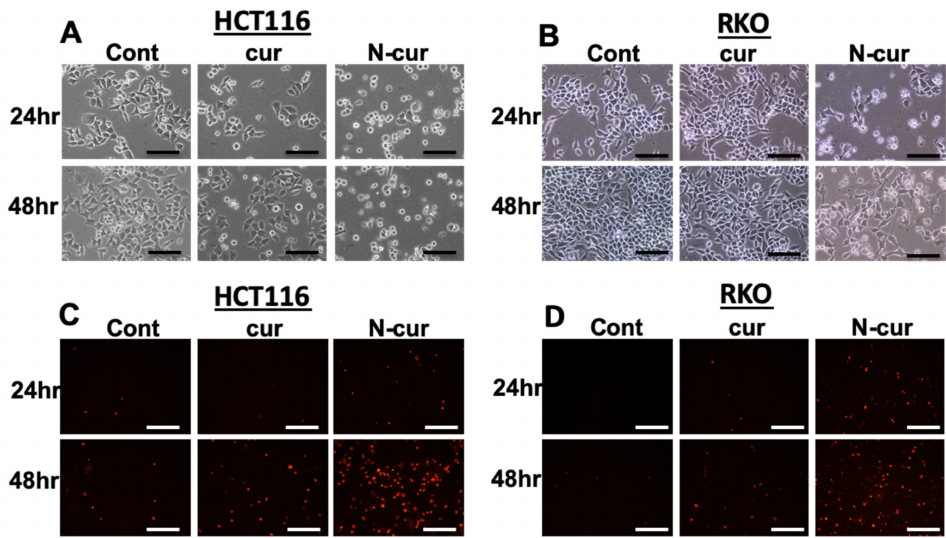
Figure 1. Effect of NO–curcumin on colon cancer cell morphology and cell death. ( A , B ) Repre- sentative phase contrasting microscopic micrographs showing the effect of curcumin (cur) and nitro-curcumin (N-cur) on HCT116 ( A ) and RKO ( B ) cell morphology and cell density after treating the cells with 40 uM of both compounds for the indicated time points. Untreated cells were used as controls. ( C , D ) Representative fluorescent microscopic micrographs of propidium idodide staining showing the effect of curcumin (cur) and nitro-curcumin (N-cur) on cell death after treating the cells with 40 µ M of both compounds for the indicated time points. Untreated cells were used as controls; size bar = 100 µ